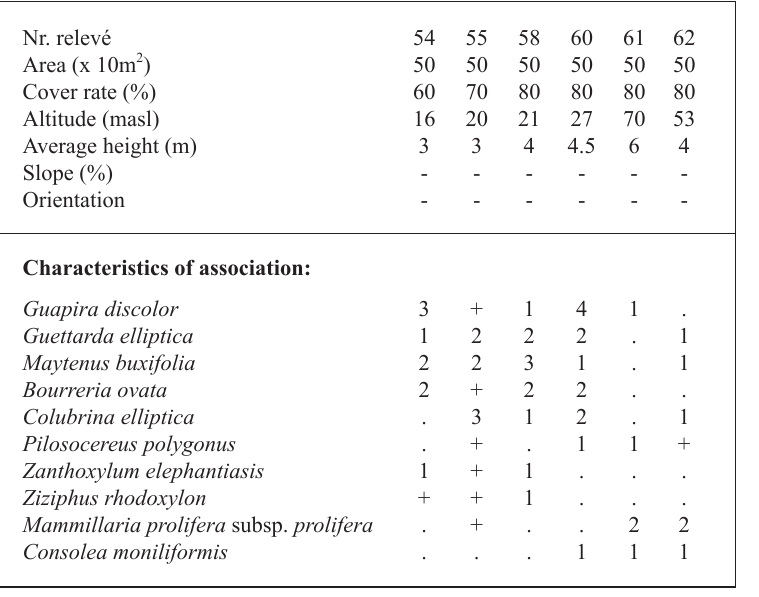
Guettardo ellipticae-Guapiretum discoloris ass.